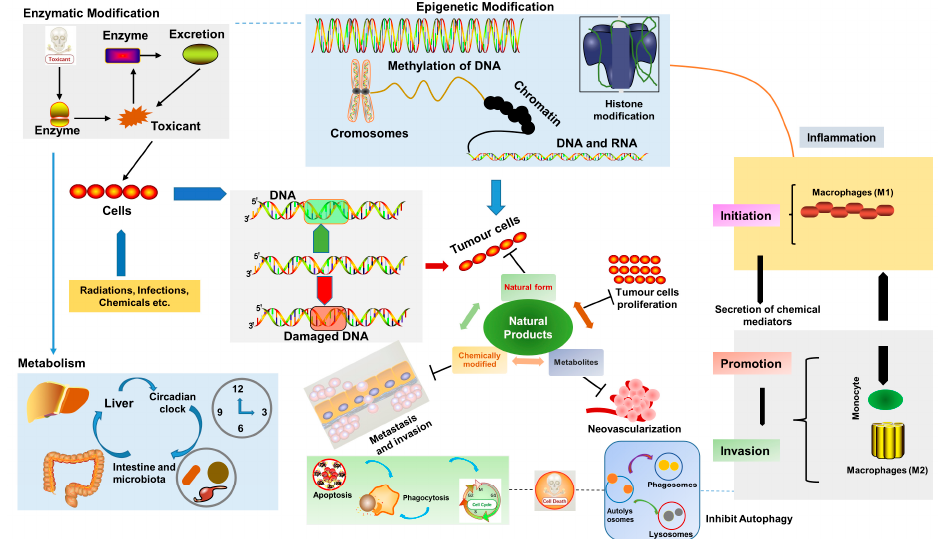
Figure 3. Several aspects of the development of cancer and the potential role of natural products in cancer prevention and therapy (adapted from [46], licensed under creative common attribution li-